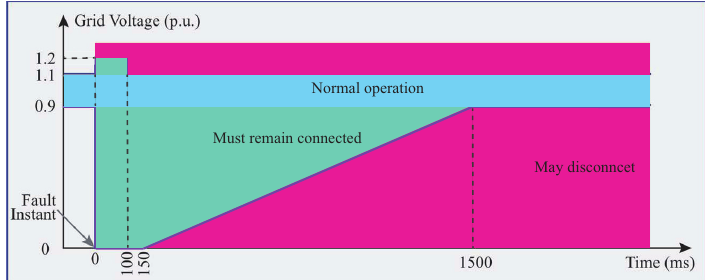
Figure 1. Fault ride-through (FRT) profiles according to the German Transmission and Distribution Utility (E.ON) regulation